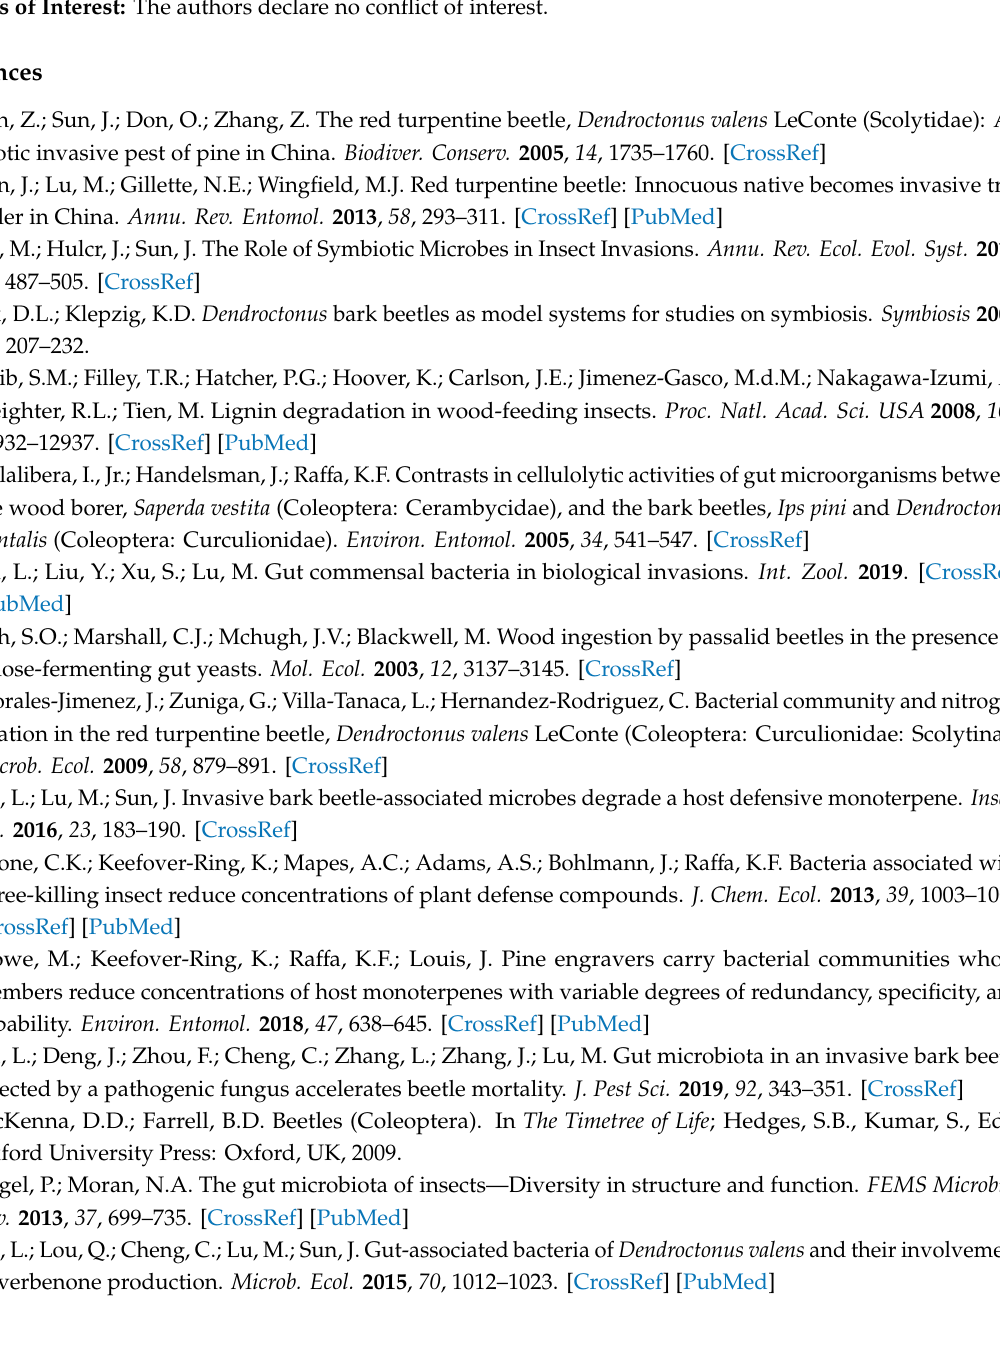
Table S1: Relative abundances of all identified species in D. valens at di ff erent life